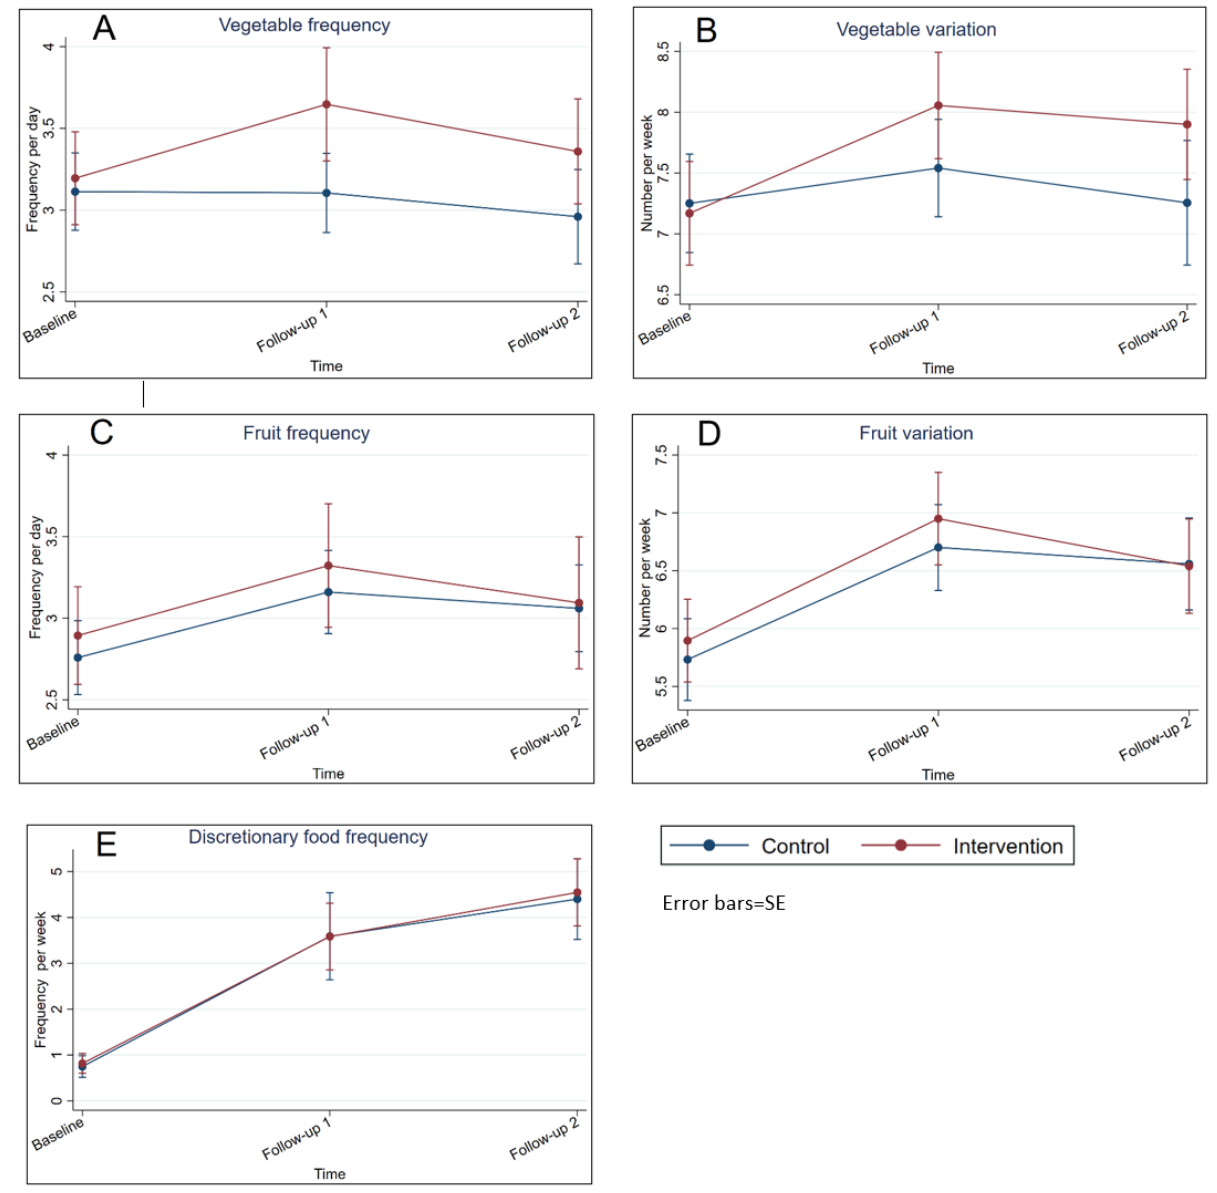
Figure 2. Estimated marginal means for children's food intake at baseline, follow-up 1, and follow-up 2 for the frequency of vegetables, fruits, and discretionary foods, and variety of vegetables and fruits. Values are adjusted for child age and gender and parental BMI, education level, and age reported at